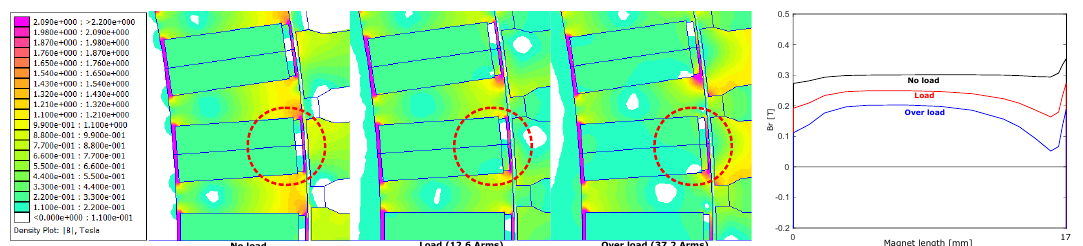
Figure 16. Demagnetization analysis of the Ferrite PM spoke motor.